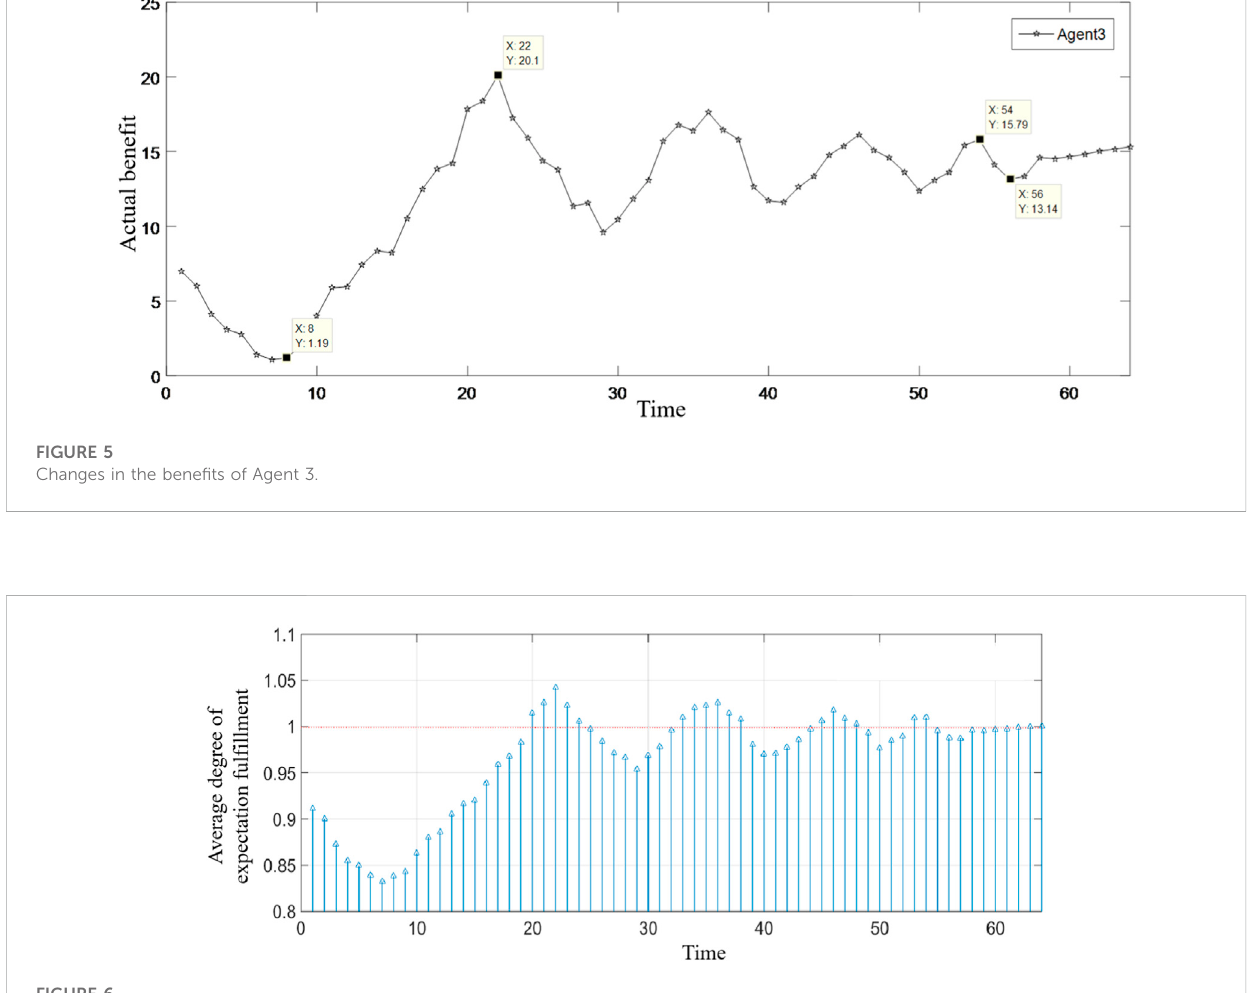
FIGURE 6 Average degree of the expected realization of member